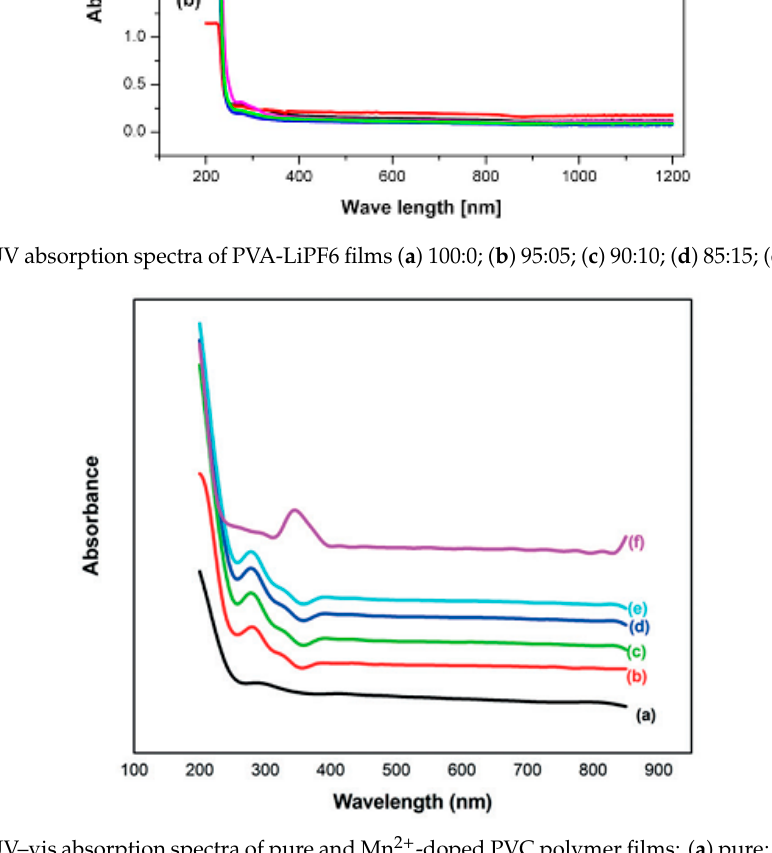
Figure 5. UV–vis absorption spectra of pure and Mn 2+ -doped PVC polymer films: ( a ) pure; ( b ) 1 mol %; ( c ) 2 mol %; ( d ) 3 mol %; ( e ) 4 mol %; ( f ) 5 mol % [77].